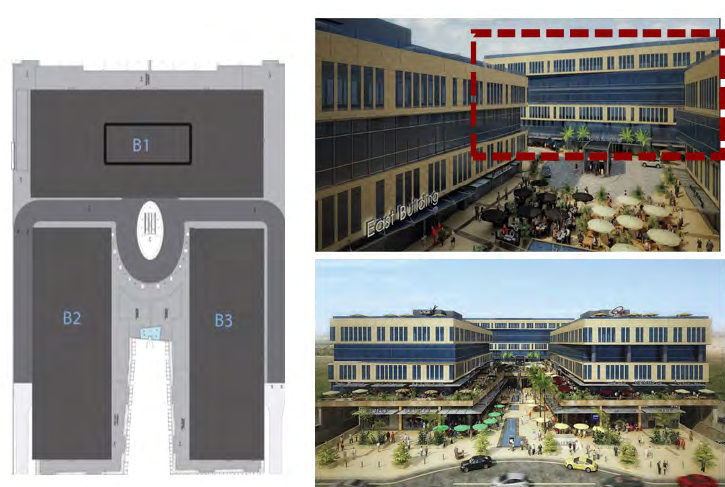
Figure 7. A mapshowing the study area and the study status of Raya Plaza Building (”Engineering Department of Raya Plaza Building”,